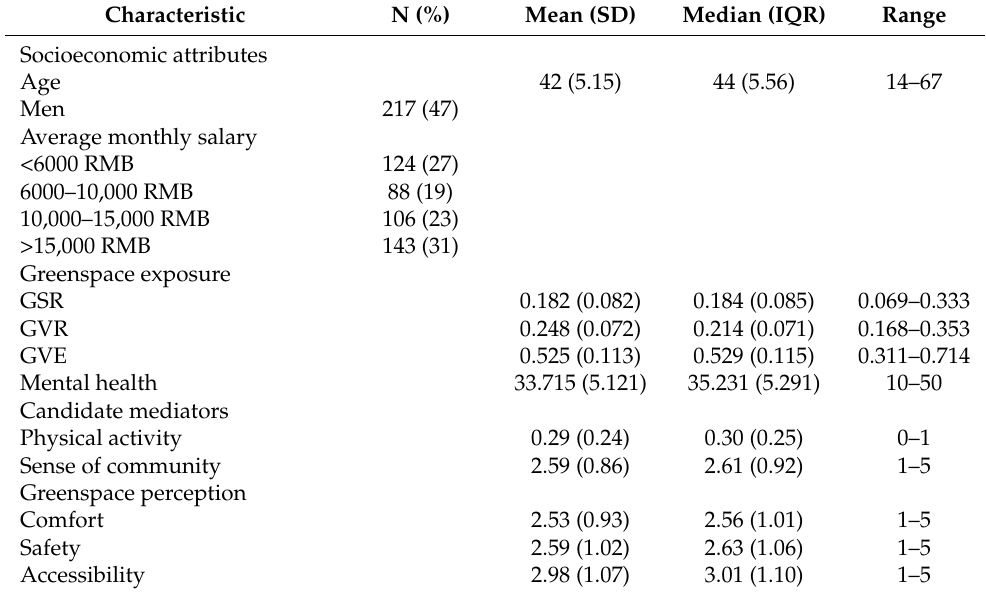
Table 7. Participant characteristics (N =